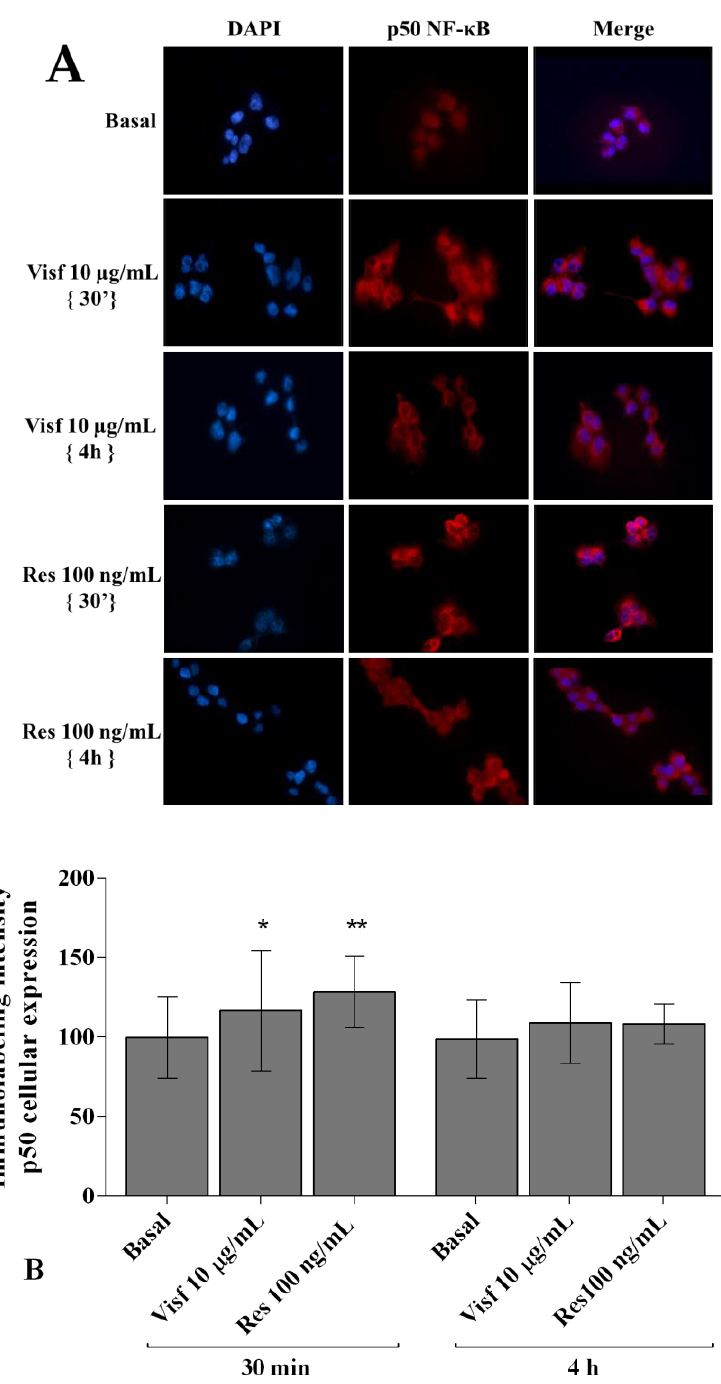
Figure 9. Immunofluorescence labeling of p50 NF- κ B subunit localization. Human osteoarthritic (OA) synovial fibroblasts were evaluated at basal condition and after 30 min or 4 h of incubation with visfatin (10 µ g / mL) and resistin (100 ng / mL). ( A ) Representative immunocytochemical images of the cells showing localization of p50 NF- κ B (red); nuclei were stained with DAPI (blue). Original Magnification 400 × . Scale bar: 20 µ m. ( B ) The histogram of immunolabeling intensity was plotted for the nuclear and cytoplasmic expression for p50 subunit. Data were expressed as mean ± SD of triplicate values. * p < 0.05, ** p < 0.01 versus basal condition. Visf = visfatin, Res = resistin.